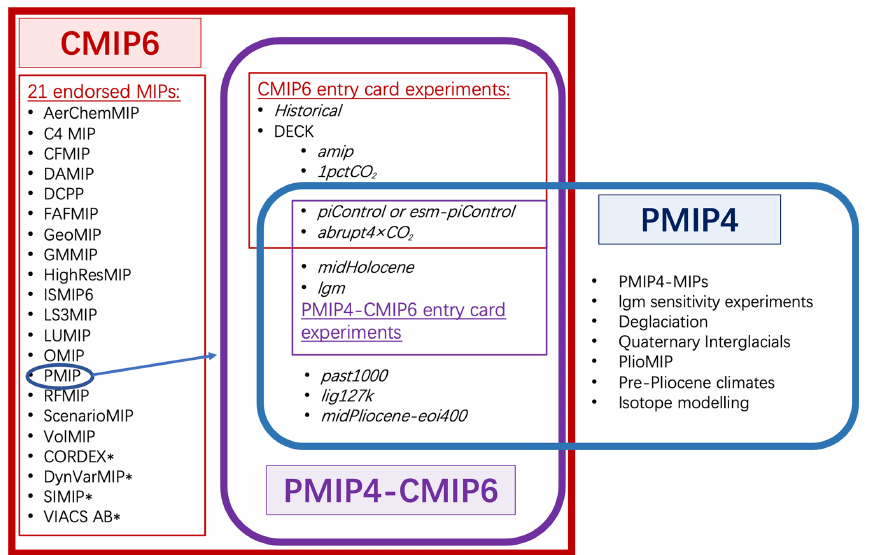
Figure 1. Schematic diagram illustrating the CMIP6 and PMIP4 experiments after Eyring et al. (2016) and Kageyama et al. (2018). “CMIP6” refers to the phase of the Coupled Model Intercomparison Project devised to support the IPCC’s Sixth Assessment Report. “PMIP4” is the fourth phase of the Palaeoclimate Modelling Intercomparison Project. We refer to the subset of models and experiments in PMIP4 that are also part of CMIP6 (purple) as